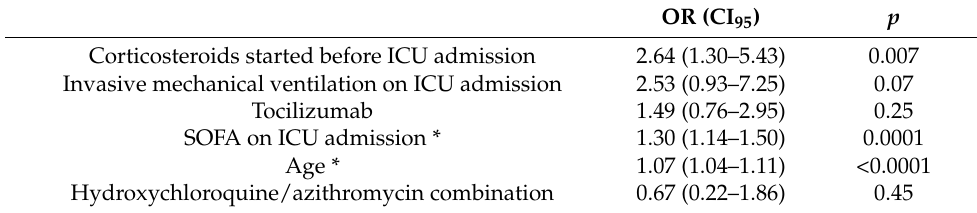
Table 2. Multivariable analysis of predictors of in-hospital mortality in 228 critically ill COVID-19 patients with pneumonia treated with